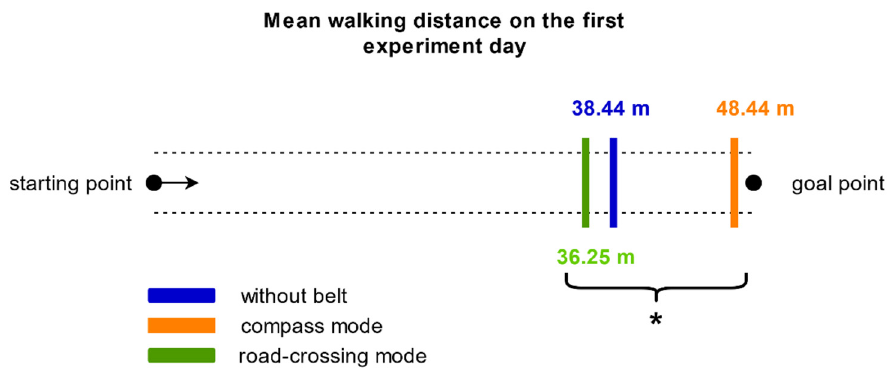
Figure 8. The mean walking distance of the blind participants on the first experiment day for the three belt conditions without belt (blue), with belt in compass mode (orange) and with belt in road-crossing mode (green) is depicted. The asterisk indicates a significant difference ( p < 0.05).